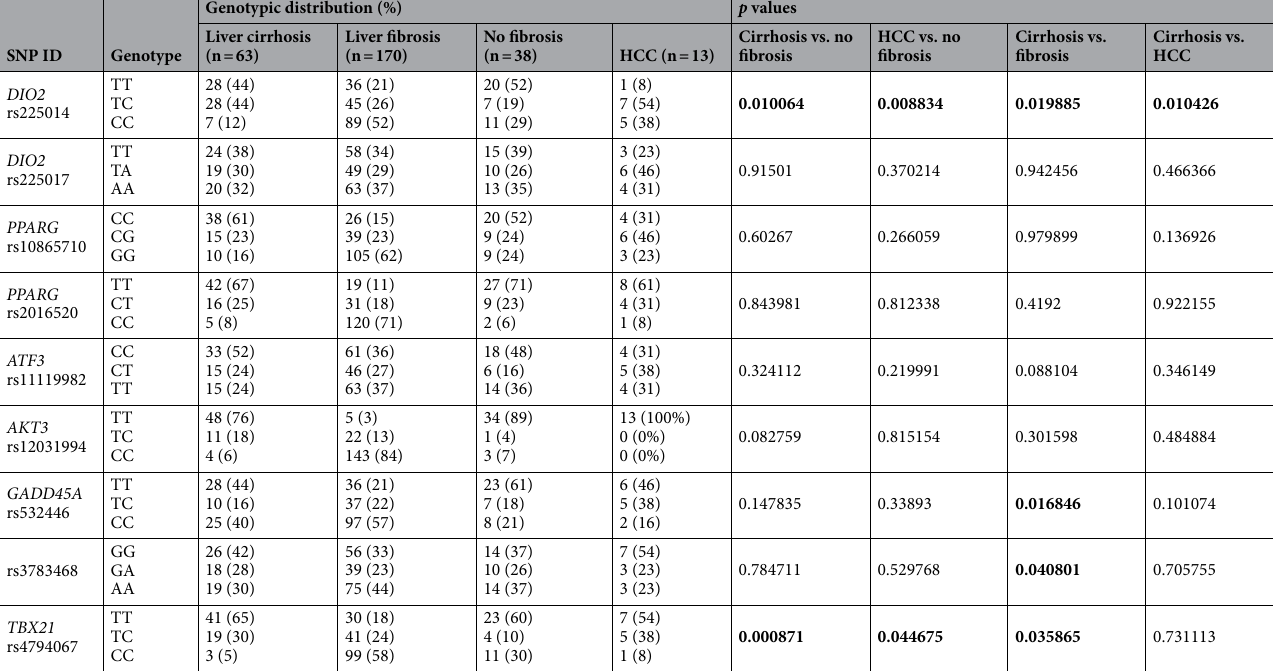
Table 2. Genotypic distribution of analyzed SNPs among chronic hepatitis B patients. HCC hepatocellular carcinoma; p values < 0.05 are marked in